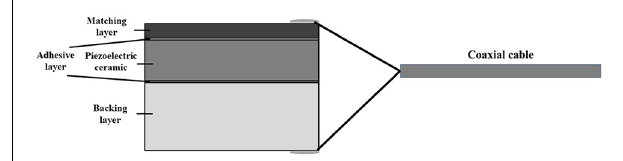
FIGURE 3 | The structural diagram of complete transducer.